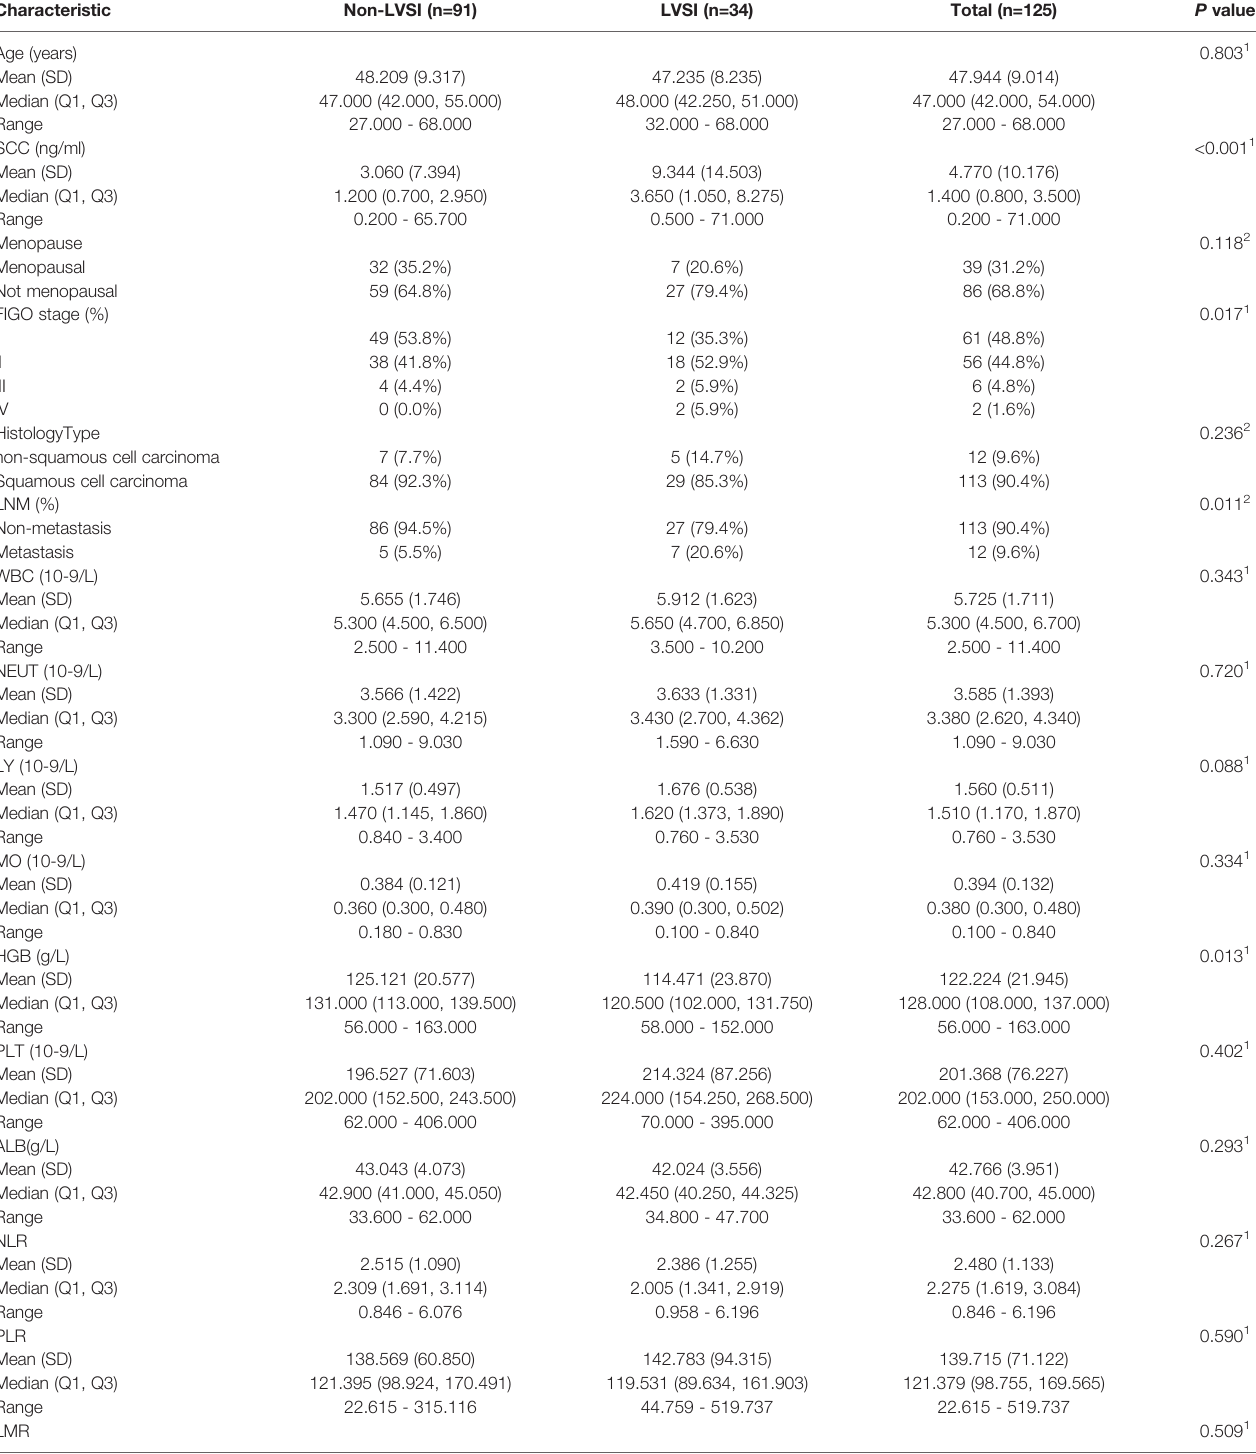
TABLE 1 | Demographic and clinicopathological characteristics of